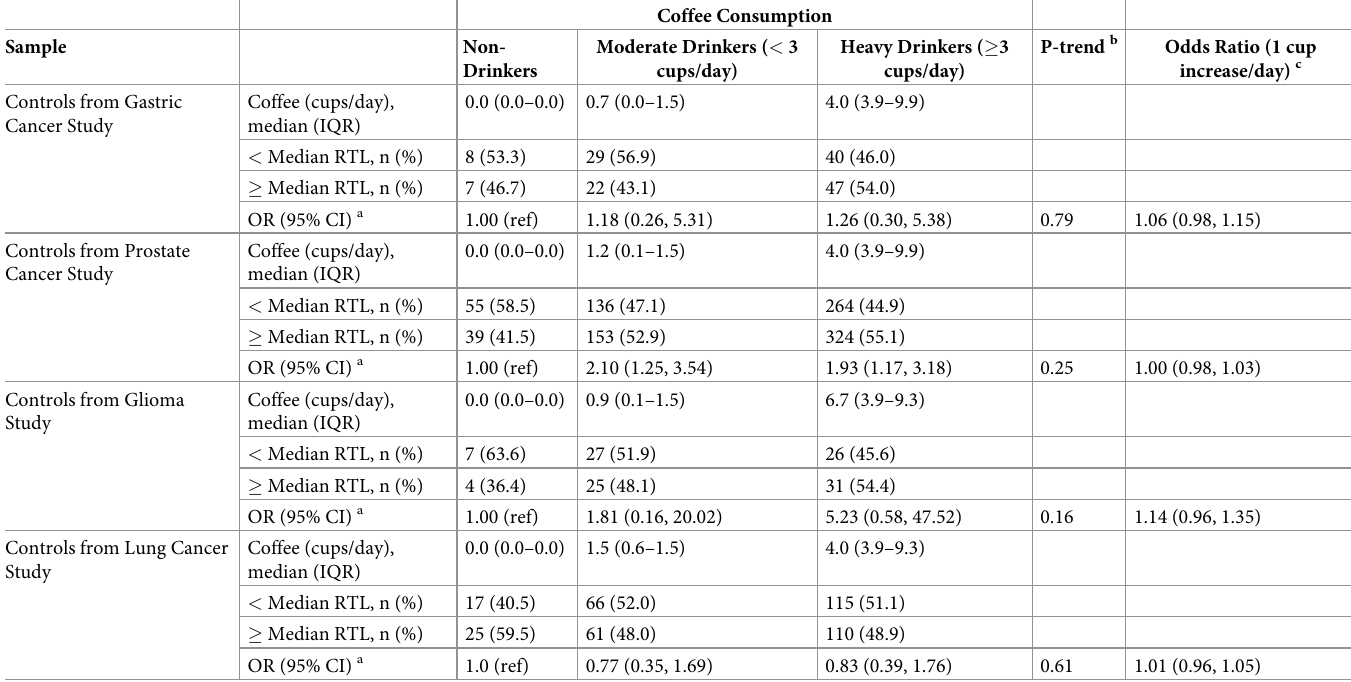
Table 3. Odds of long RTL associated with coffee